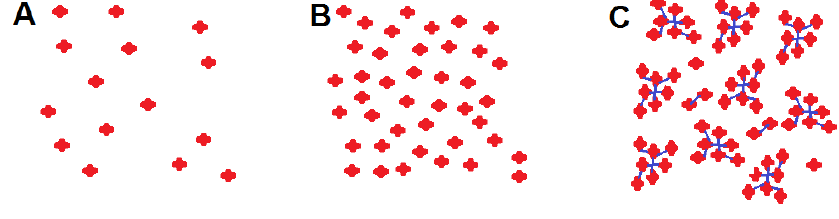
) for the TFOH-1 aggregates (chloroform, h